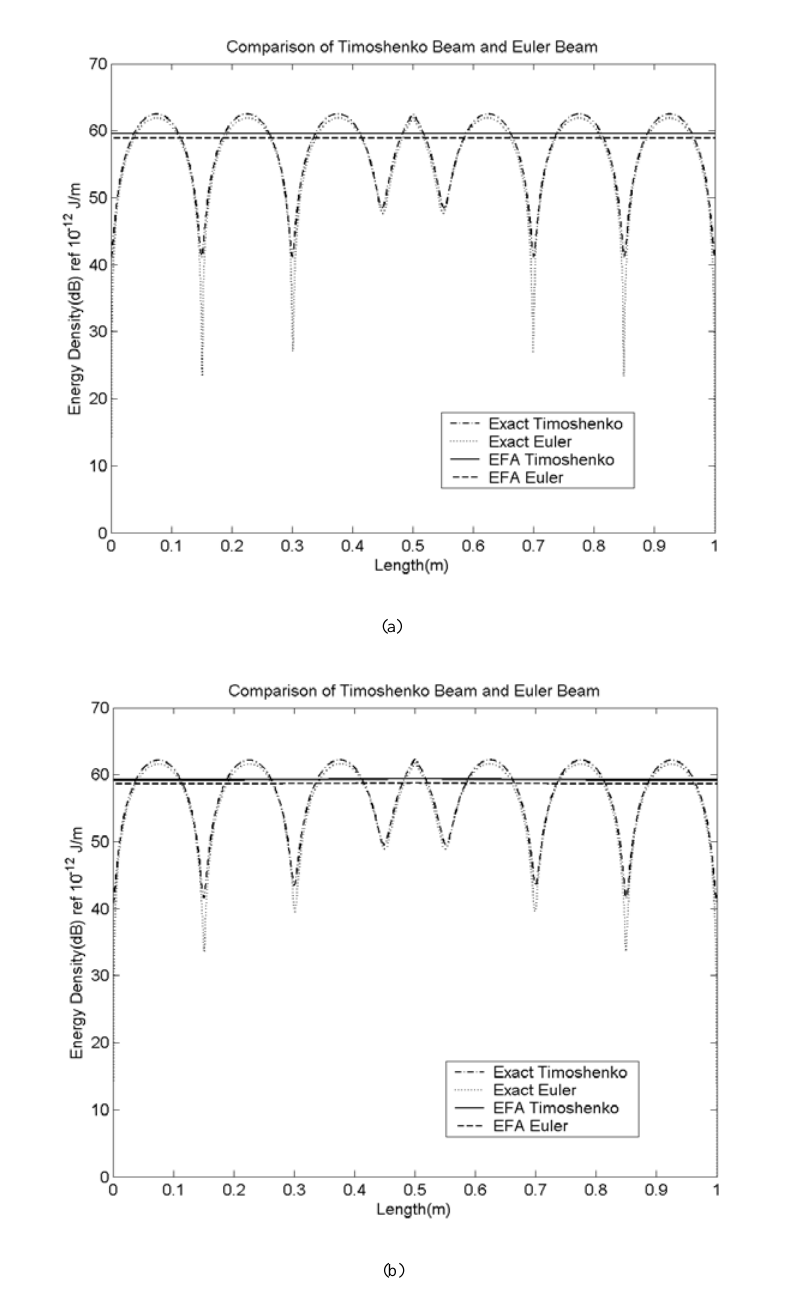
Fig. 4. The energy density level distributions of the Timoshenko beam ( L / H = 100, f c = 159 kHz) when f = 1 kHz. The reference energy density is 10 − 12 J/m: (a) η = 0.01, (b) η = 0.05, (c) η = 0.1, (d) η = 0.2: - · - · -, classical solution of the Timoshenko beam; ····· , classical solution of the Euler-Bernoulli beam, —, EFA solution of the Timoshenko beam; ---, EFA solution of the Euler-Bernoulli beam. not considered in the Euler-Bernoulli beam theory, become dominant. Additionally, the effects of rotatory inertia and shear distortion cause the energy density from the Timoshenko beam model to decay faster than that from the Euler-Bernoulli beam model because the energetic damping term ( ηω / c g ) of the structure becomes large as the excitation frequency